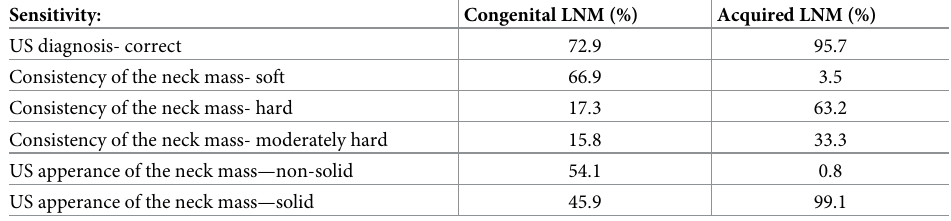
Table 3. Values of sensitivity for ultrasound and clinical examinations of congenital and acquired lateral neck masses in